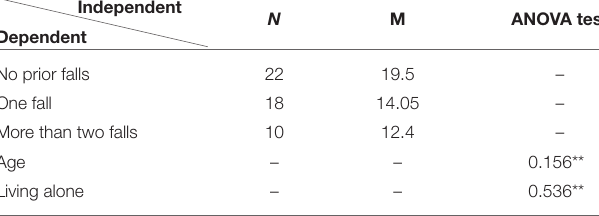
TABLE 6 | Independent variable: “having a good day”